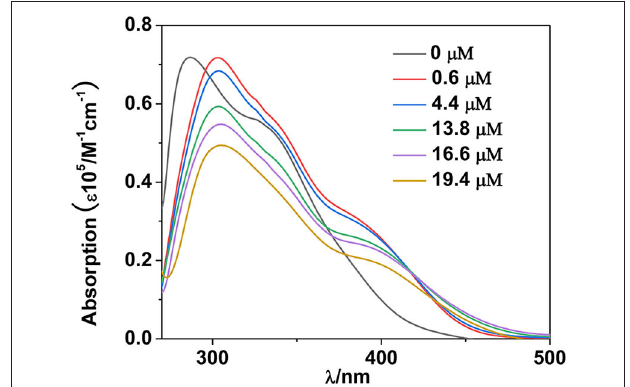
FIGURE 10 | UV-visible spectra of 1 with the addition of H 2 PO 2 − anion at 298K.